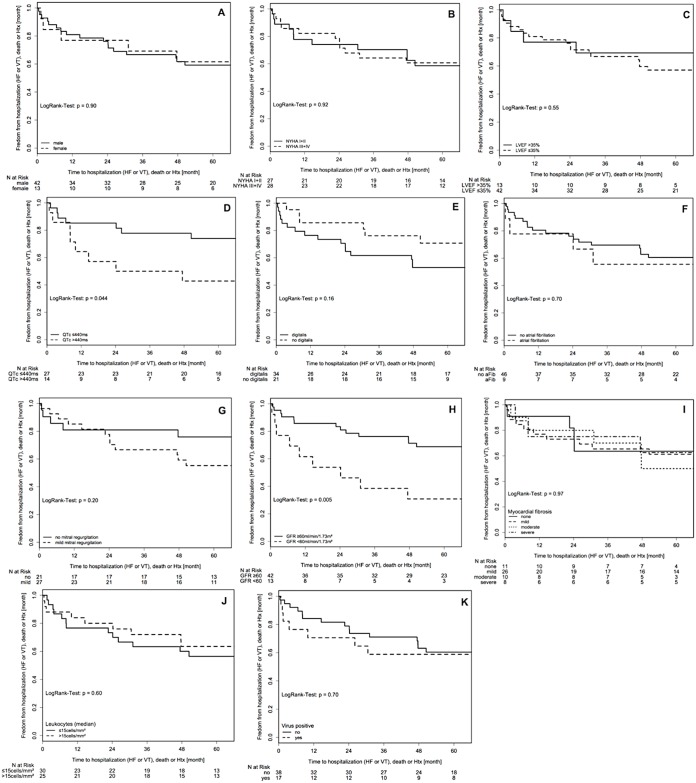
(a-k). Unadjusted survival free from death, heart transplantation and hospitalization for heart failure or ventricular arrhythmias in relation to clinical, laboratory, electrocardiographic, echocardiographic parameters and immunohistochemical parameters.a: gender; b: NYHA functional class; c: left ventricular ejection fraction (LVEF); d: QTc interval; e: treatment with digitalis; f: atrial fibrillation; g: mitral regurgitation; h: glomerular filtration rate (GFR), i: myocardial fibrosis, j: inflammatory cell count on endomyocardial biopsy, k: viral genome detection.